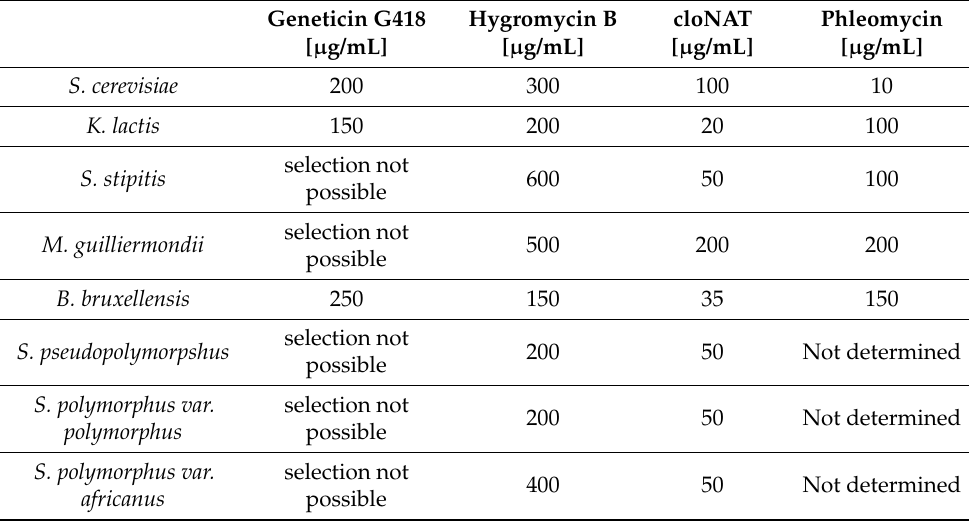
Table 1. Antibiotic concentrations which can be used for selection of yeast transformants on solid YPD media.